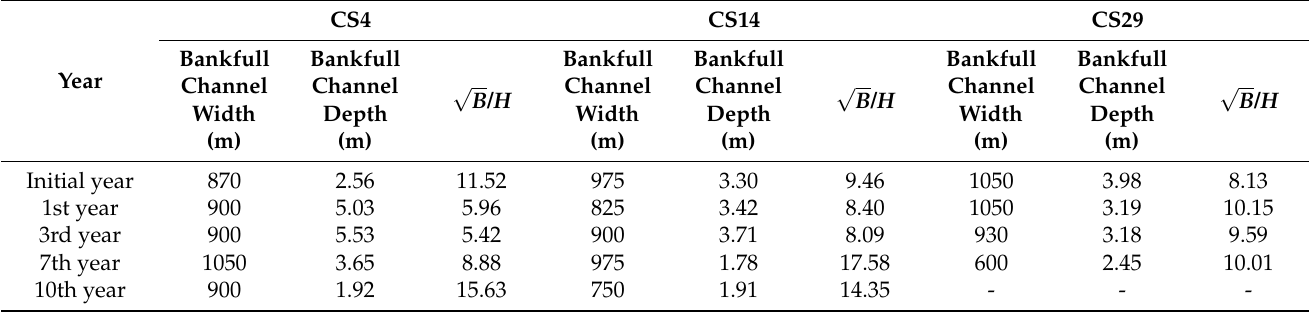
Table 2. Statistics of the bend section shape parameters constrained by four